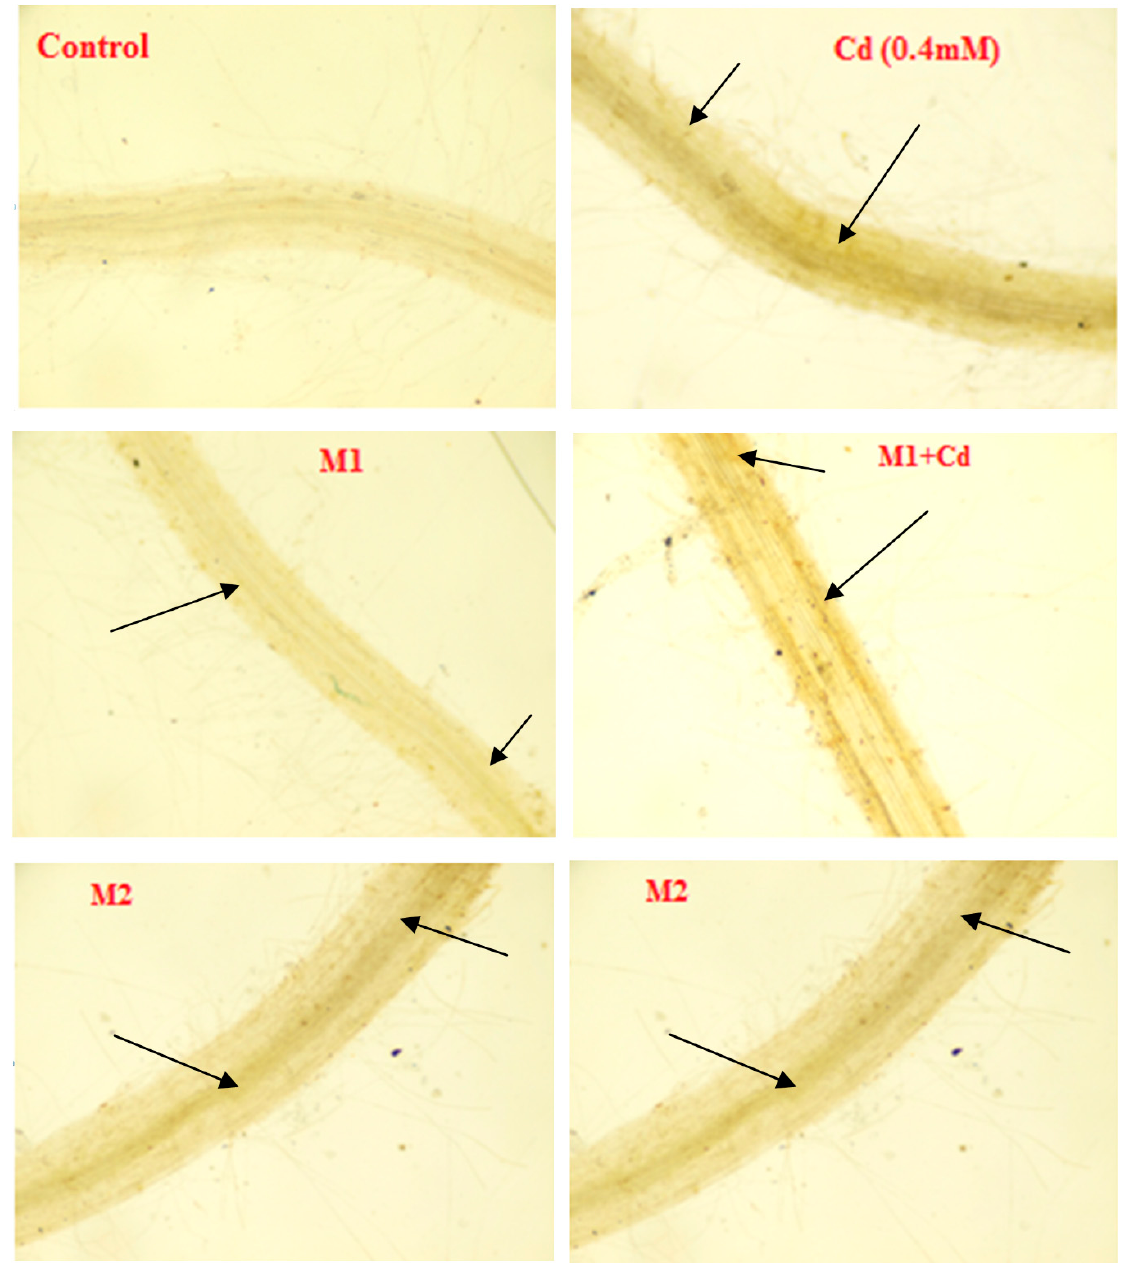
Figure 3. Studies showing phenol accumulation in L. esculentum root sections stained with Fast Blue BB through visible microscopy.